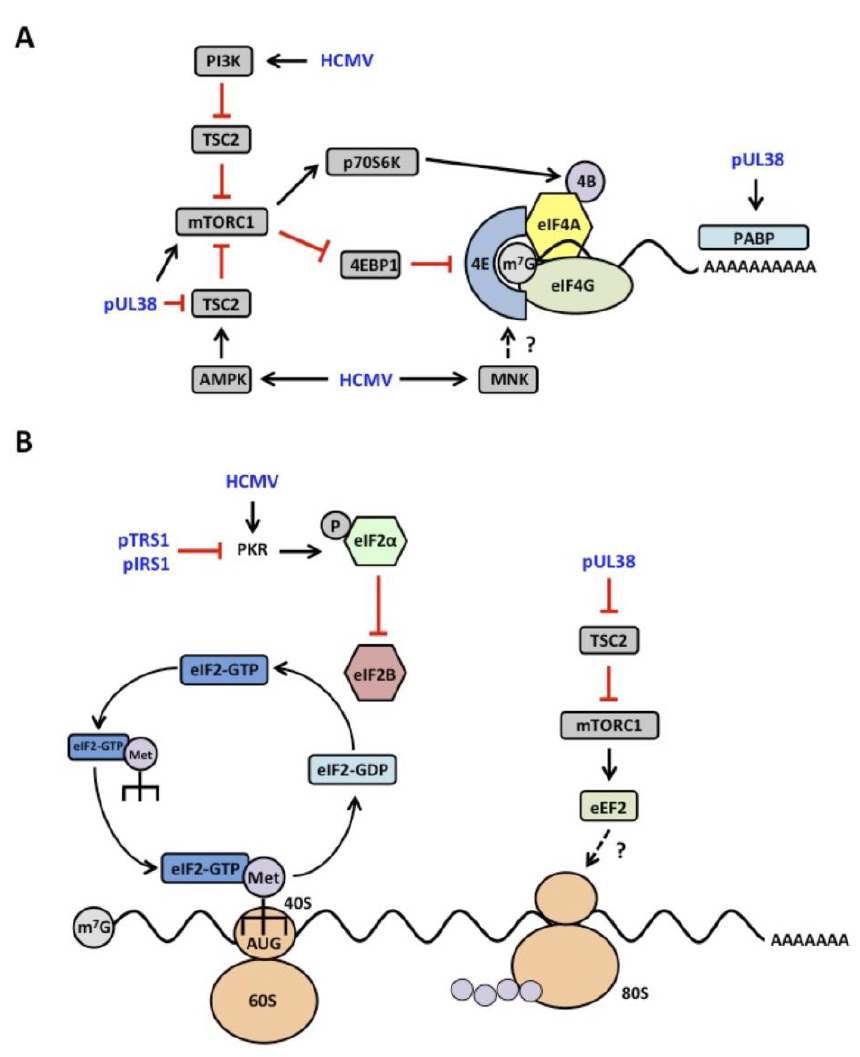
Figure 1 . Schematic of human cytomegalovirus (HCMV) manipulation of translation initiation and elongation. (A) HCMV stimulates eIF4F formation and activity through multiple mechanisms. and elongation. ( A ) HCMV stimulates eIF4F formation and activity through multiple mechanisms. Infection increases levels of eIF4F components (eIF4E, eIF4G, eIF4A) and poly(A) binding protein (PABP). HCMV also promotes eIF4F assembly by activating mammalian target of rapamycin complex